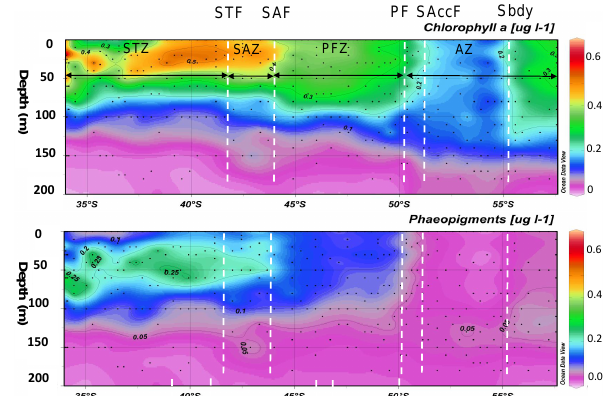
Figure 3 c, d (cont.). Profiles of chlorophyll-a and phaeopigments in the upper 200 m of the water column along the Bonus-Goodhope cruise track (Taken from Beker et al, 2011). Elevated pigment concentrations were observed in equatorward of the Subtropical Front. Frontal positions are indicated by the white vertical dotted lines.